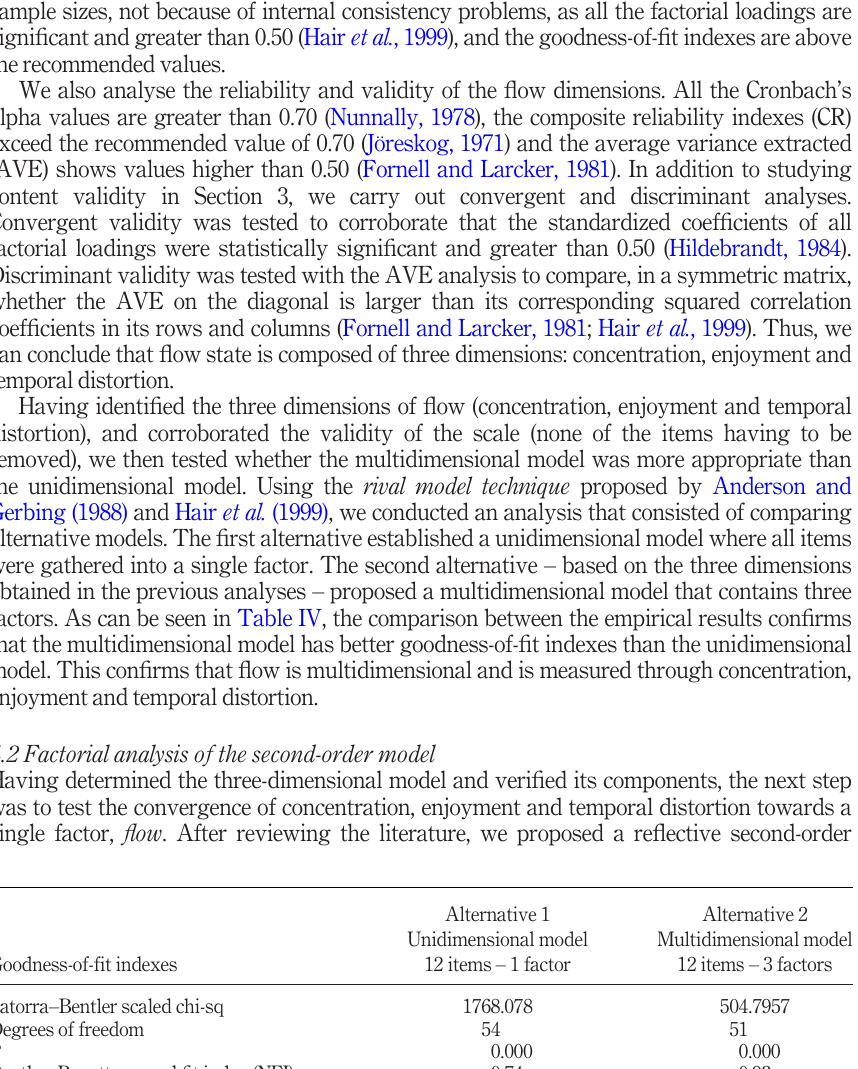
Comparison between unidimensional